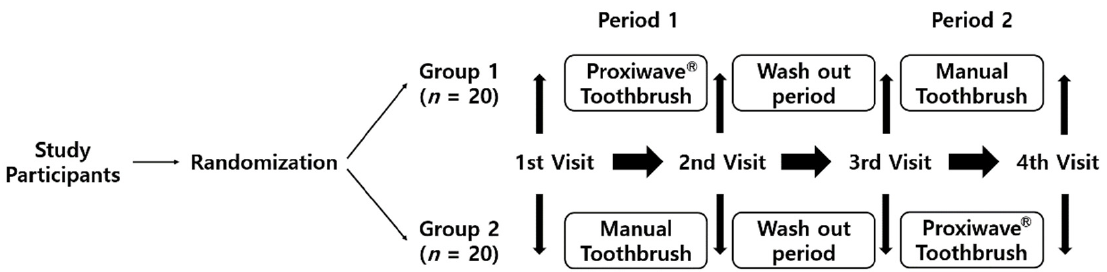
Figure 1. Flow chart of the study.